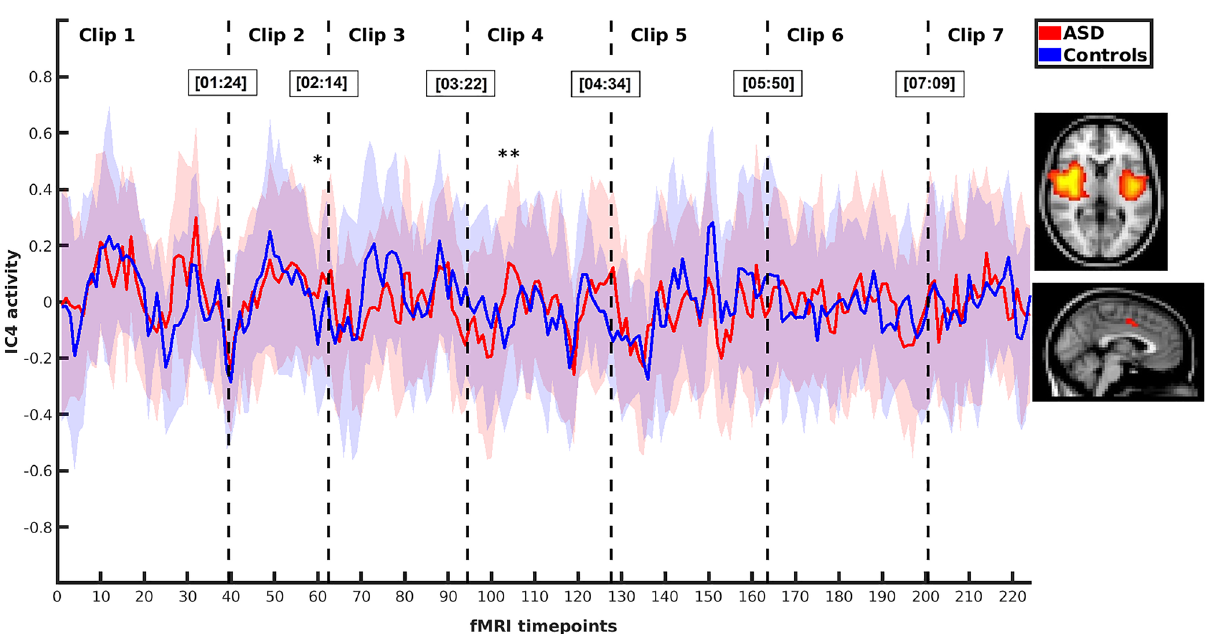
Figure 2. Average activity (± SD ) of IC4 in the ASD and NT groups during video clips 1–7 (* = significant difference after combining probability over IC4, IC15 and